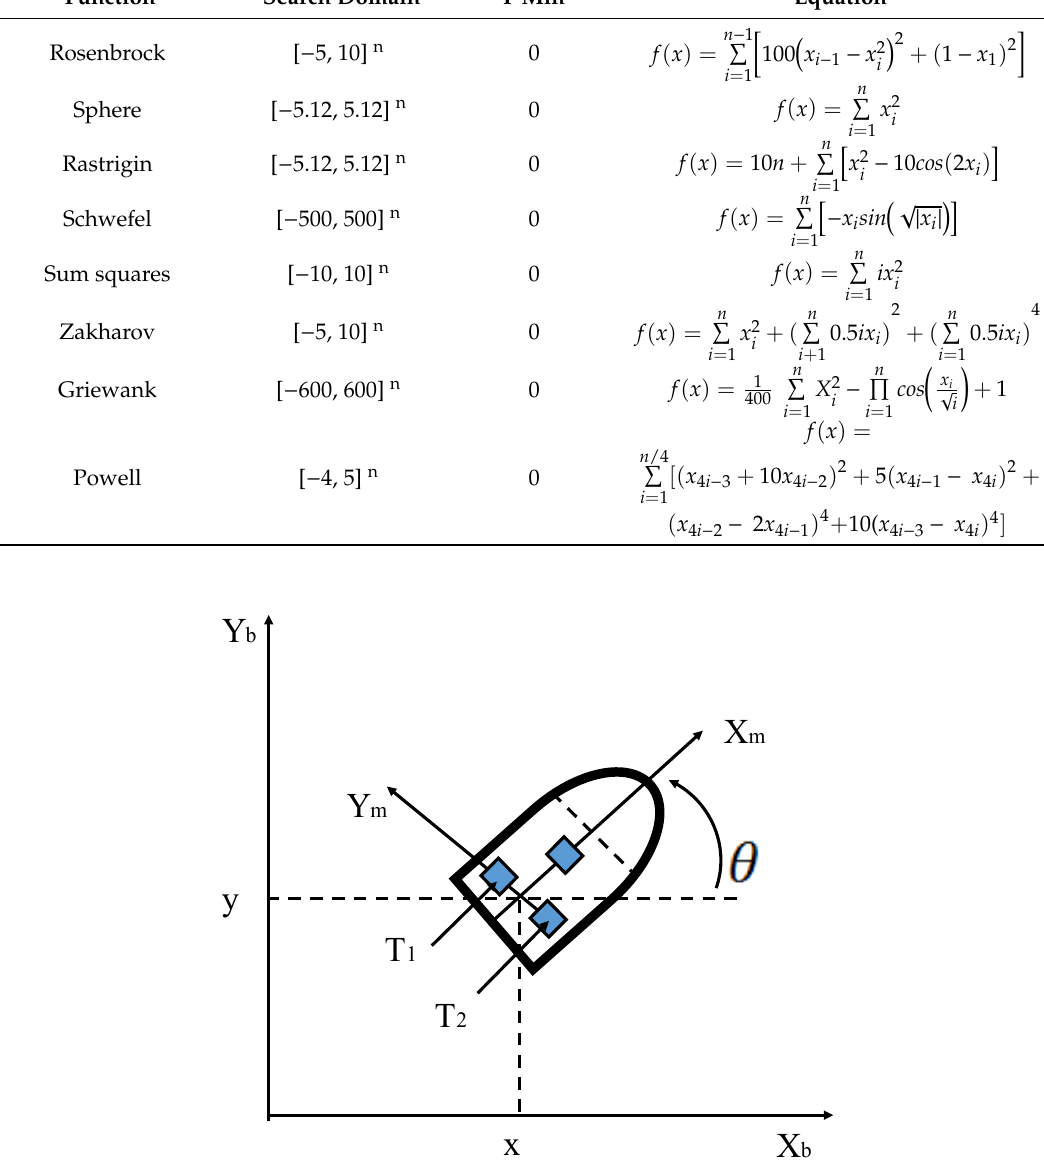
Figure 6. Diagram of the robot mobile controller.